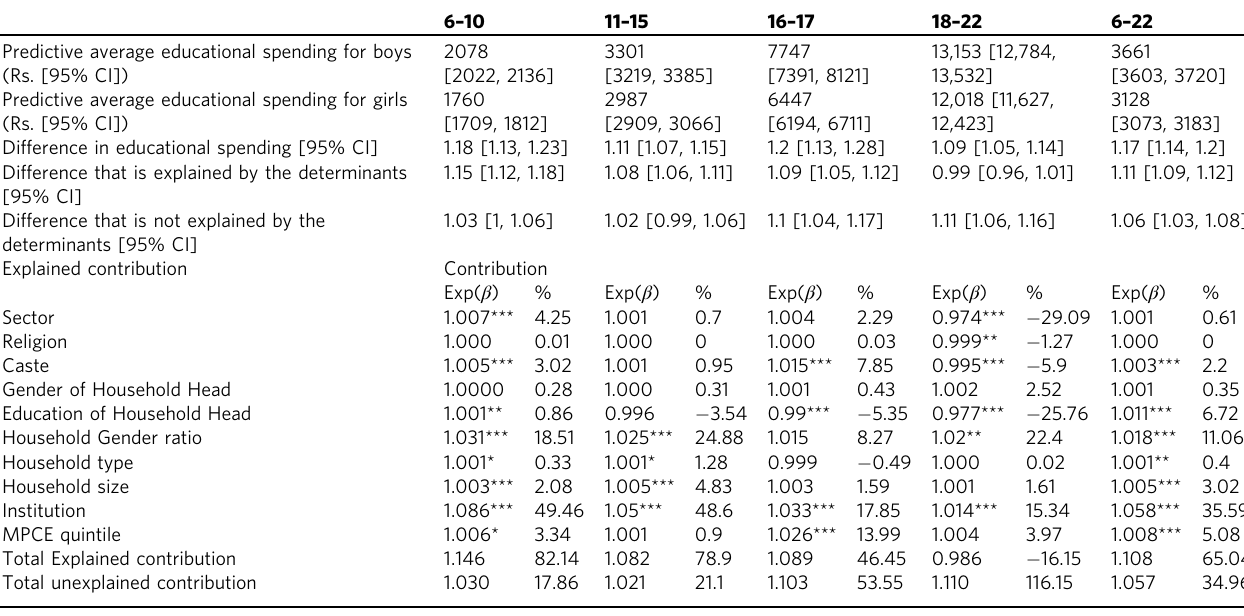
Table 5 Blinder-Oaxaca Decomposition analysis depicting the contribution of characteristics in gender gap of household educational spending across ages (2017 – 18),